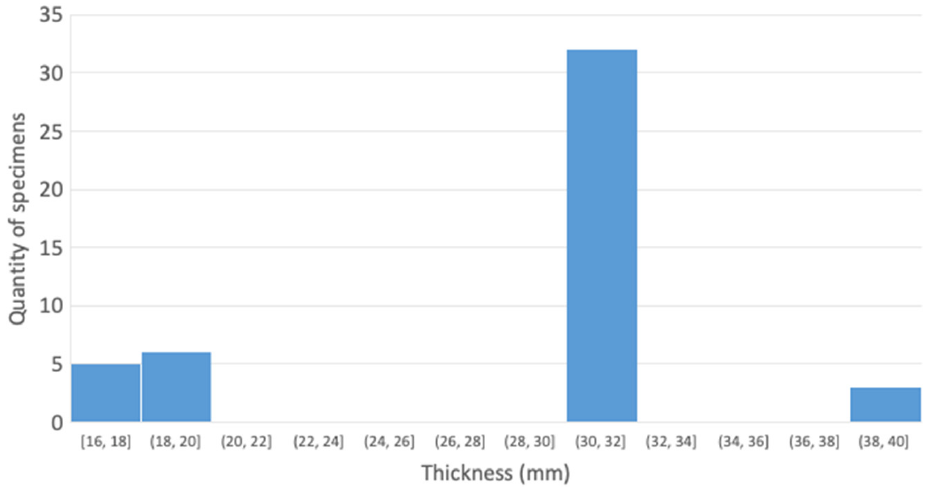
Figure 19. Histogram of thickness with CP tubular joint Figure 21. Histogram of thickness with CP tubular joint samples . Figure 21. Histogram of thickness with CP tubular joint samples .